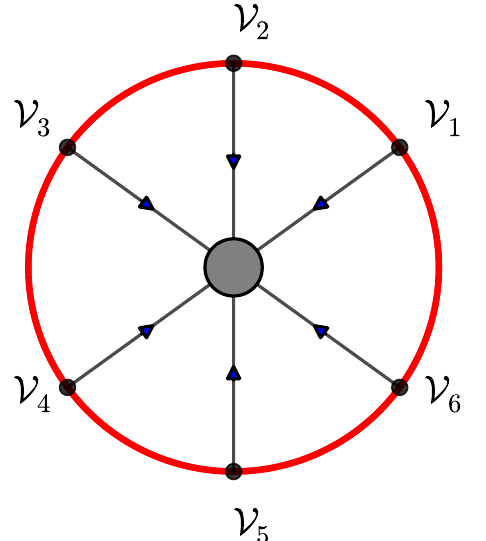
Figure 4 . The Euclidean S -matrix is obtained from the boundary correlators by placing the source corresponding to the i -th particle at (cid:18) i = (cid:22) (cid:12) i + (cid:25)